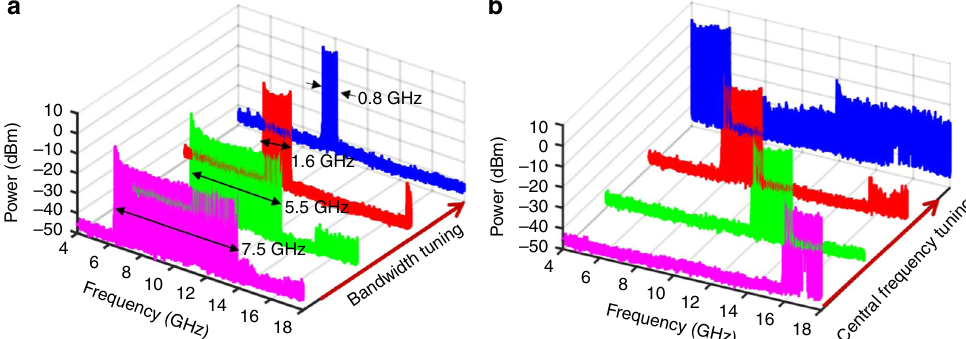
Fig. 4 Tuning of the generated microwave waveforms. a The scanning range is tuned from 0.8 GHz to 7.5 GHz with a central frequency of 10 GHz. b The central frequency is tuned from 5 GHz to 17 GHz with a scanning range of 2 GHz